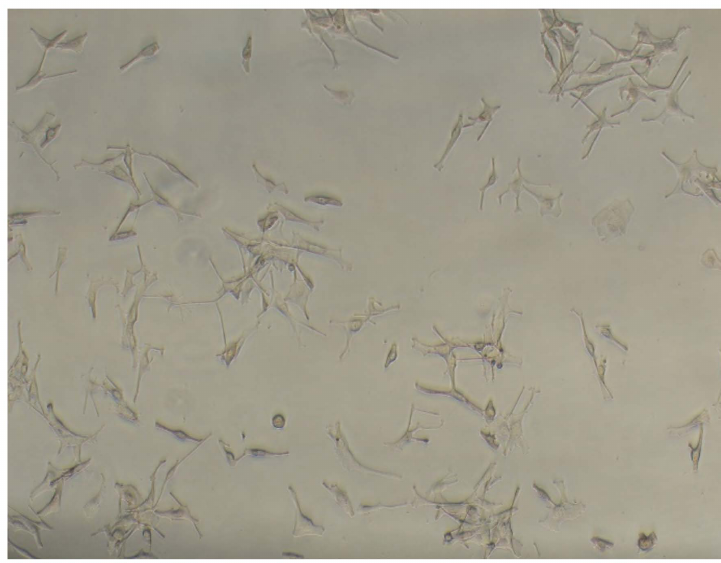
Figure 3. Normal human epidermal melanocytes (NHEMs) during